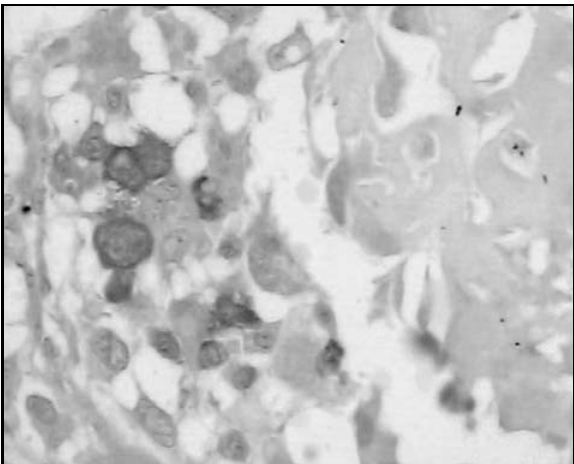
Figura 3 – c- erb-B2: expressão membranosa e citoplasmática em osteossarcomas (IH 400x)